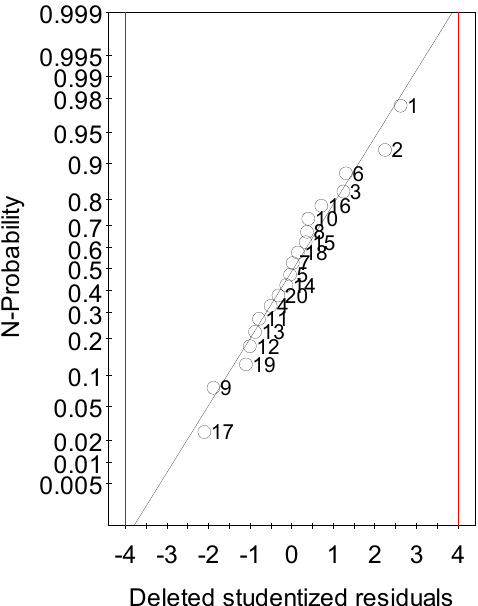
Figure 3. Normal probability plot of the studentized deleted residuals.